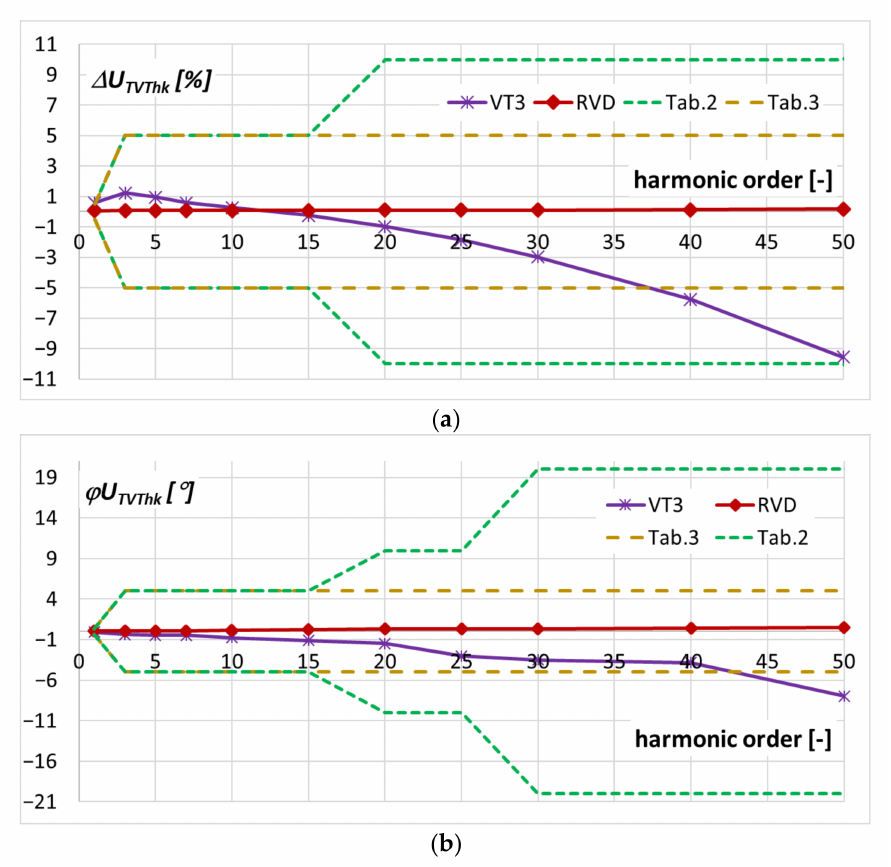
√ 3) kV and the wideband reference voltage divider: